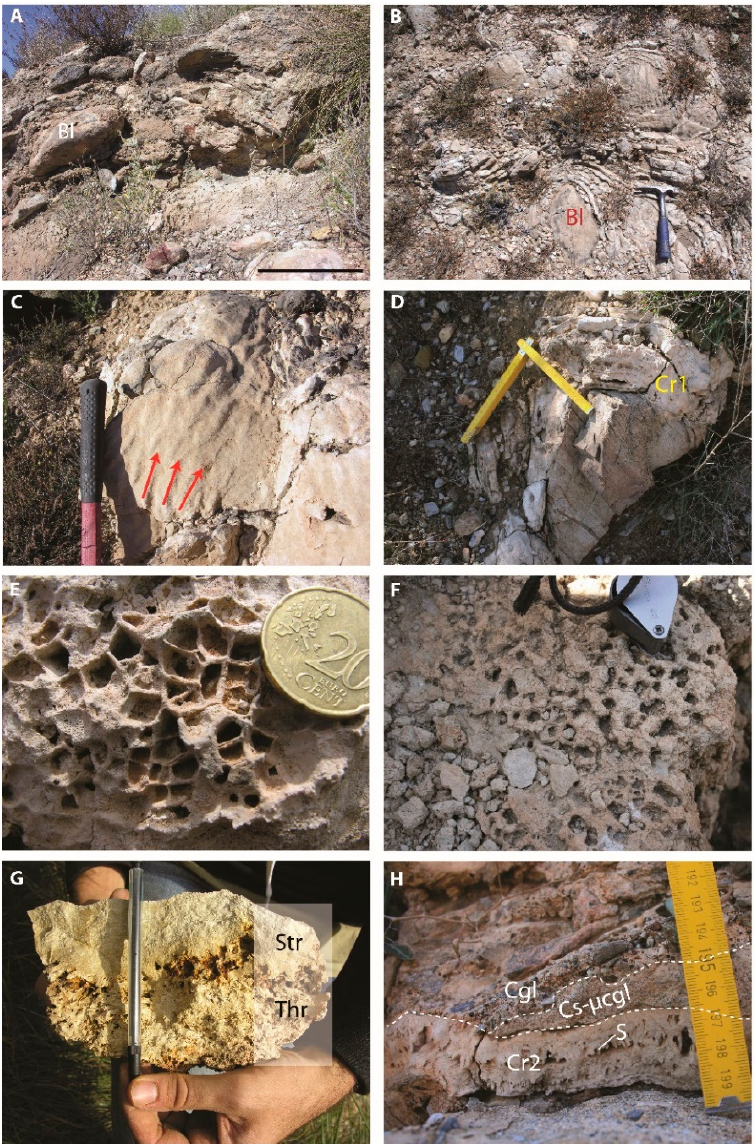
Figure 7. Macro-, mesofabrics of Microbialite Association 1 (MA1) and associated sedimentary features. ( A ) Stromatolitic crust on alluvial fan conglomerates (Bl = boulders). Cariatiz, DS4. The scale bar is 30 cm. ( B ) Surface-view of a stromatolitic crust (Cr1; Table 1) encrusting boulders (Bl). Cariatiz, DS4. The hammer is 30 cm long. ( C ) Close-up view of a crust. Red arrows indicate crests of what could be wave-ripples on the stromatolite surface. Cariatiz, DS4. The visible part of the hammer is 30 cm long. ( D ) Stromatolitic crust (Cr1) on a siliciclastic boulder. The lamination is poorly defined, probably because of a strong post-depositional alteration and cementation of the microbialite. Cariatiz, DS4. One segment of the ruler is 20 cm long. ( E ) Polygonal boxwork structures interpreted as the result of evaporite dissolution atop a wavy to hemispheroid stromatolite. Cariatiz, DS3. ( F ) Surface view of millimeter to centimeter circular ducts cross-cutting small hemispheroids and wavy laminites on several decimeters. Cariatiz, DS4. The magnifying glass is 2 cm wide. ( G ) Section in a hemispheroid with a thrombolitic core (Thr) and a stromatolitic envelope (Str). The irregularity of the transition between the two mesofabrics is probably exaggerated by posterior dissolution. South of Santa Pola. The pencil is 14 cm long. ( H ) Thrombolitic crust (Cr2) including coarse sands (S), incised by an erosional surface covered by coarse sands to microconglomerates (Cs- µ cgl) themselves eroded by a gravel conglomerates (Cgl) Cariatiz, DS4.